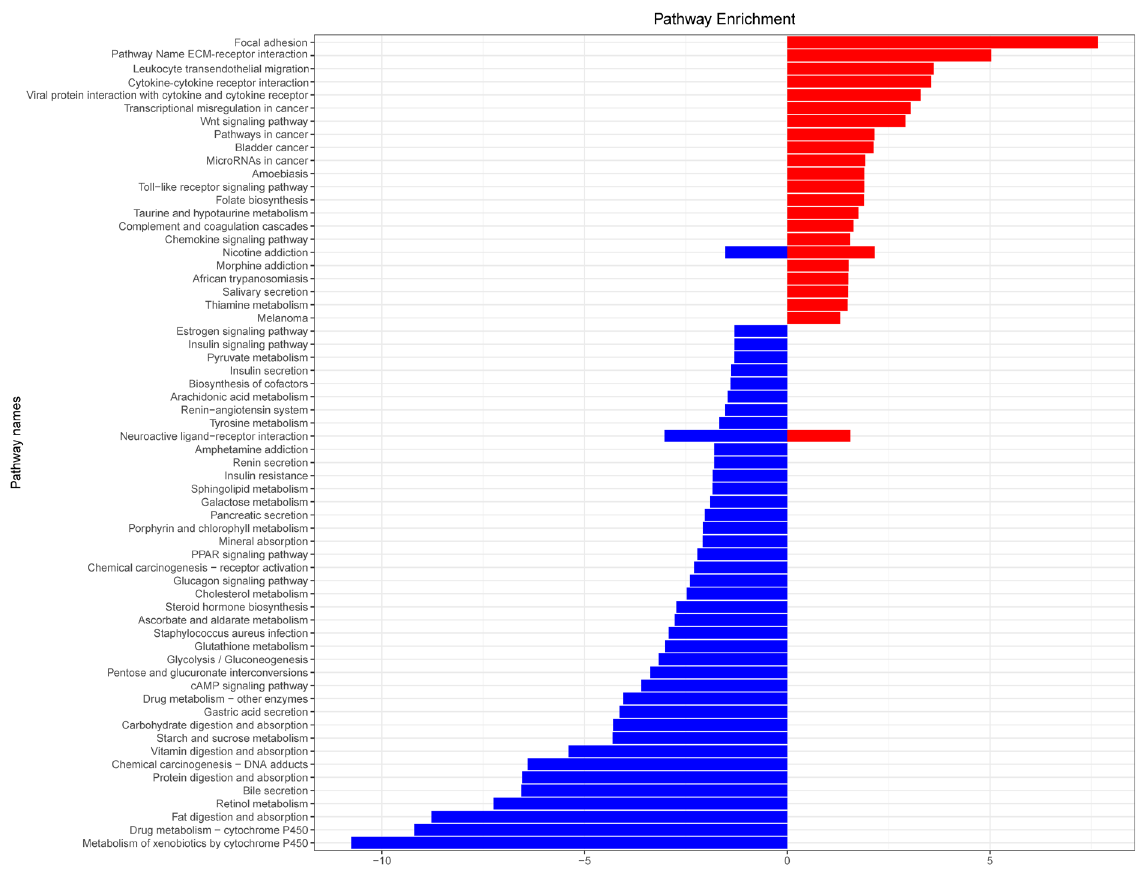
Figure 3. KEGG pathway analysis of differential genes in gastric cancer. Red represents UDEGs, and blue represents DDEGs. PPAR: peroxisome proliferator-activated receptor; cAMP: cyclic adenosine monophosphate